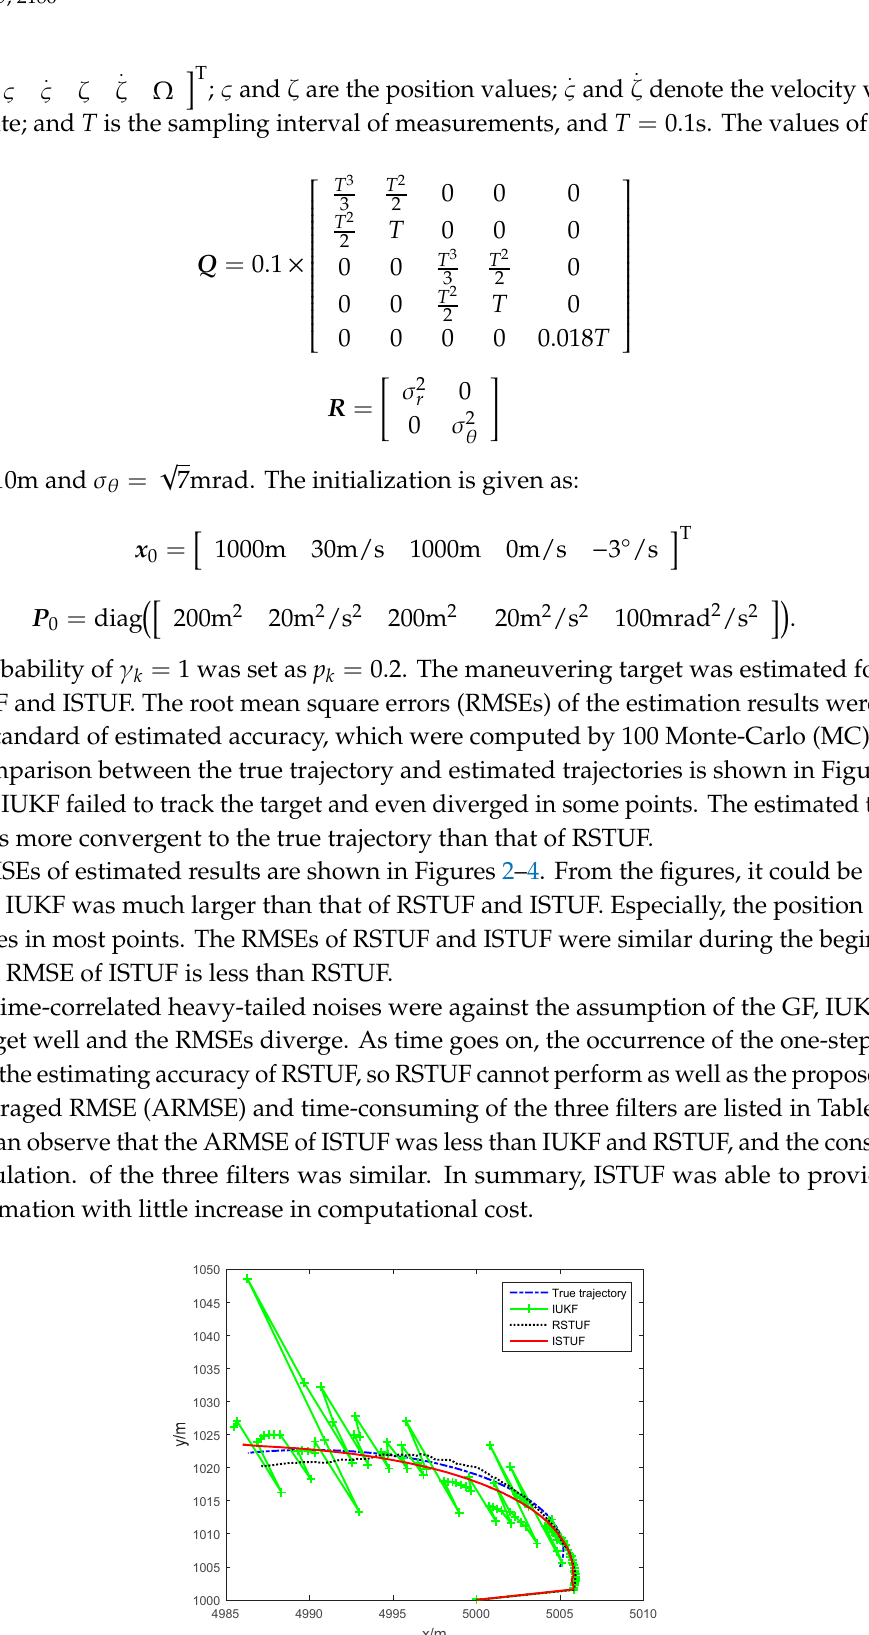
Figure 2. RMSE of estimating position. Figure 3. RMSE of estimating velocity .